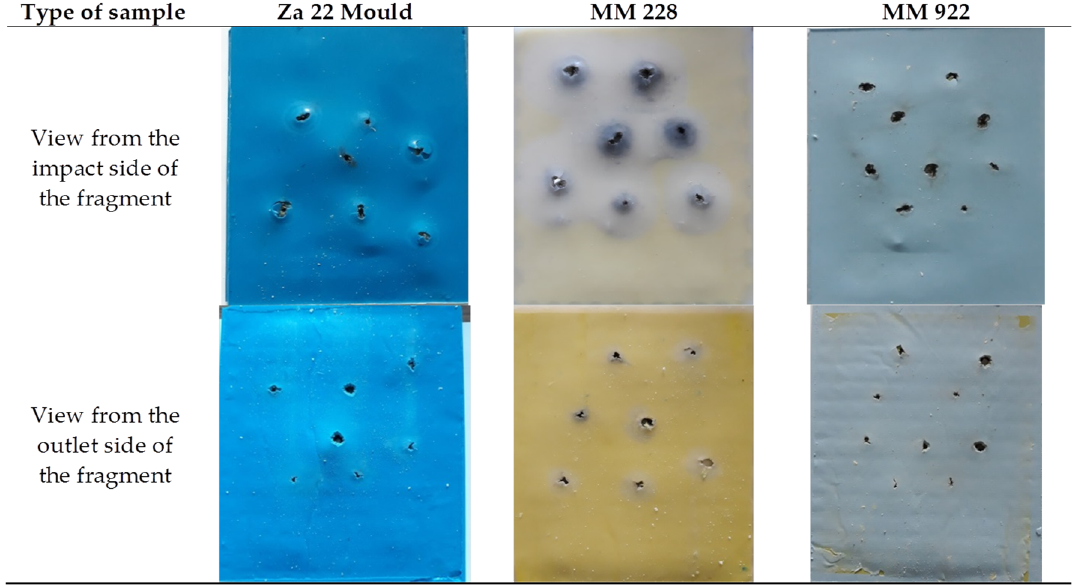
Figure 4. Hybrid ceramic-silicone composites after ballistic